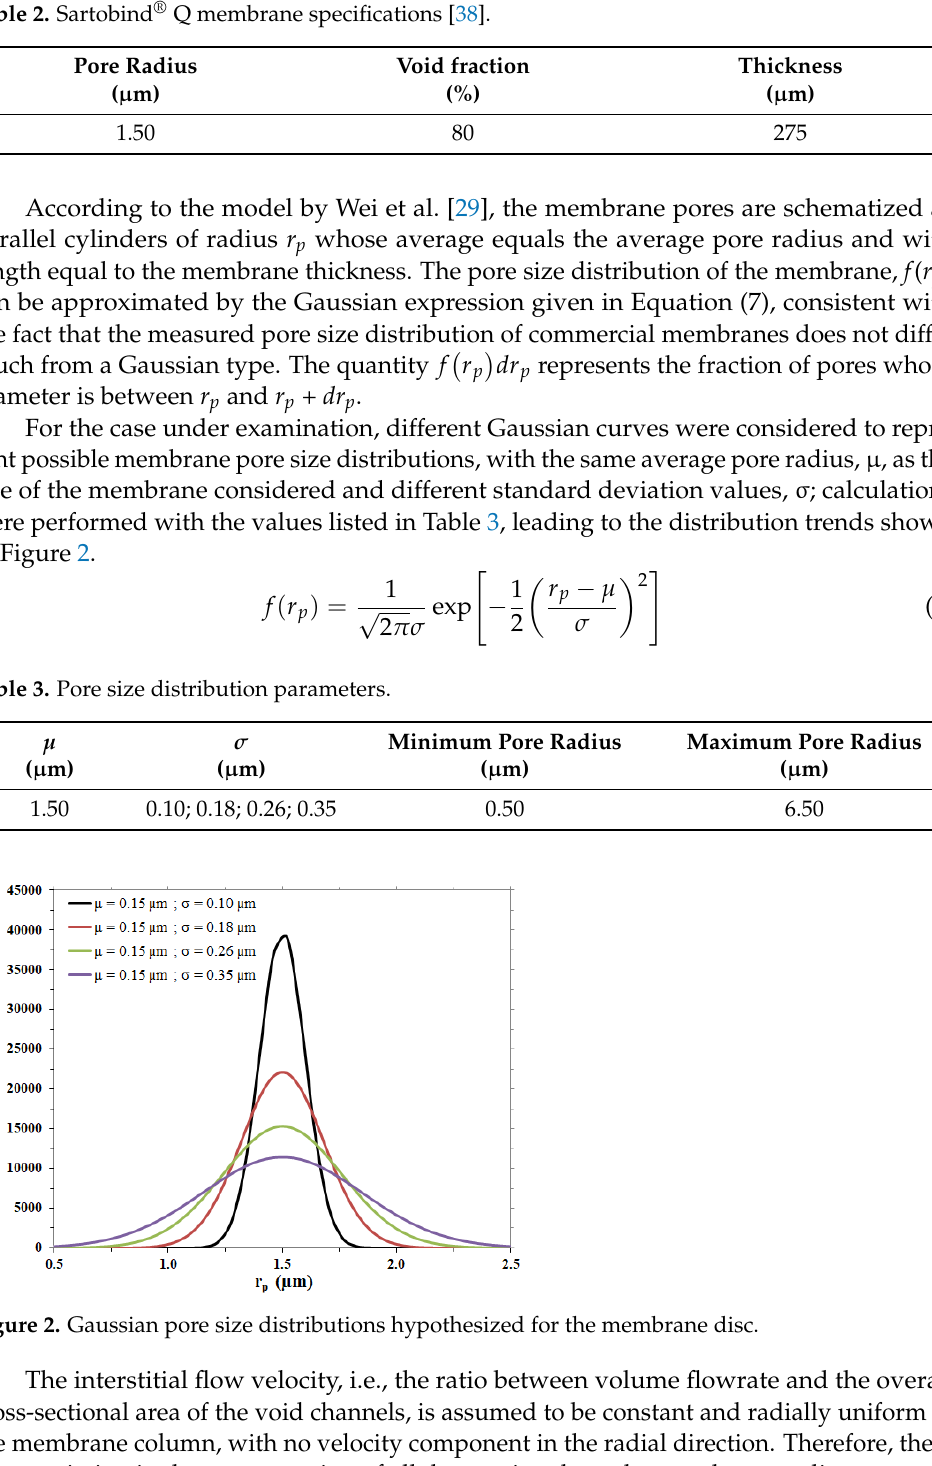
Table 2. Sartobind ® Q membrane specifications [38].